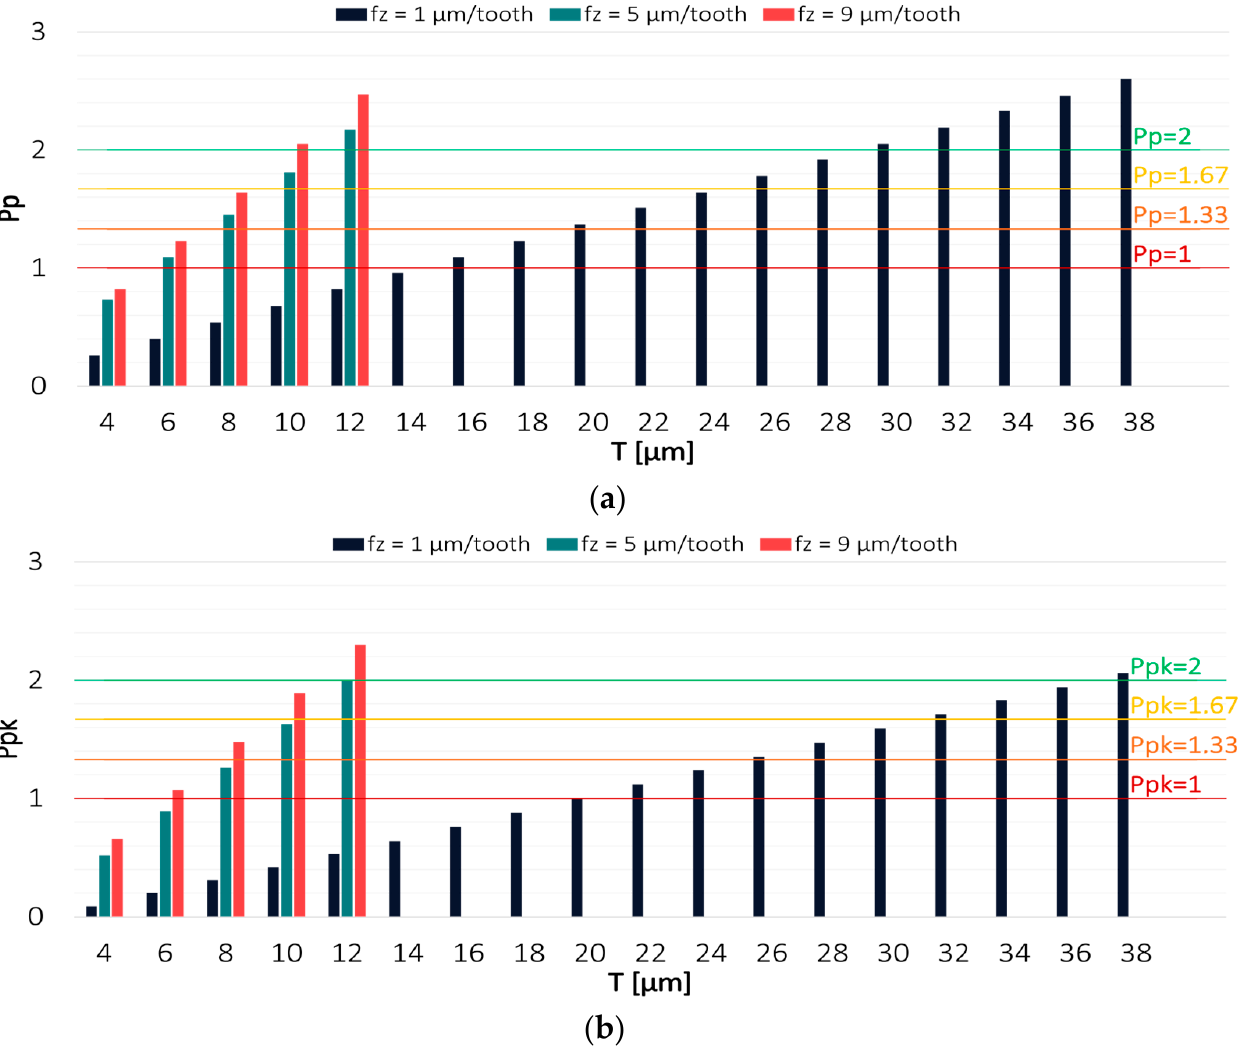
Figure 7. Values of ( a ) Pp and ( b ) Ppk for the results obtained in a milling process conducted with variable feed per tooth and TiB 2 -coated tool.